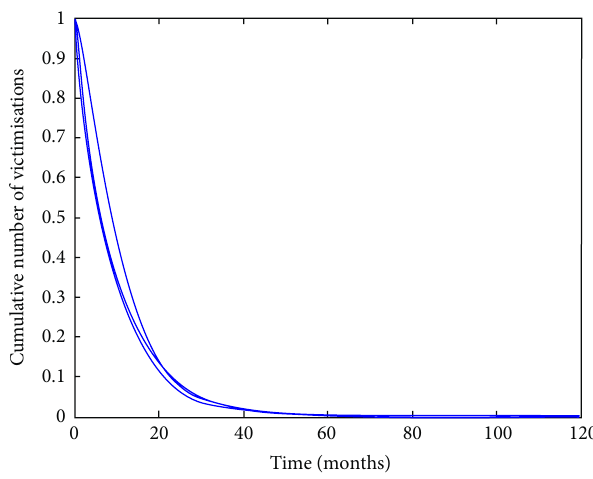
Figure 10: Simulation of model (4) using various initial conditions, showing cumulative number of victimisation cases when and . Other parameter values used are as given in in Table 3. 𝛽 2 = 0.05